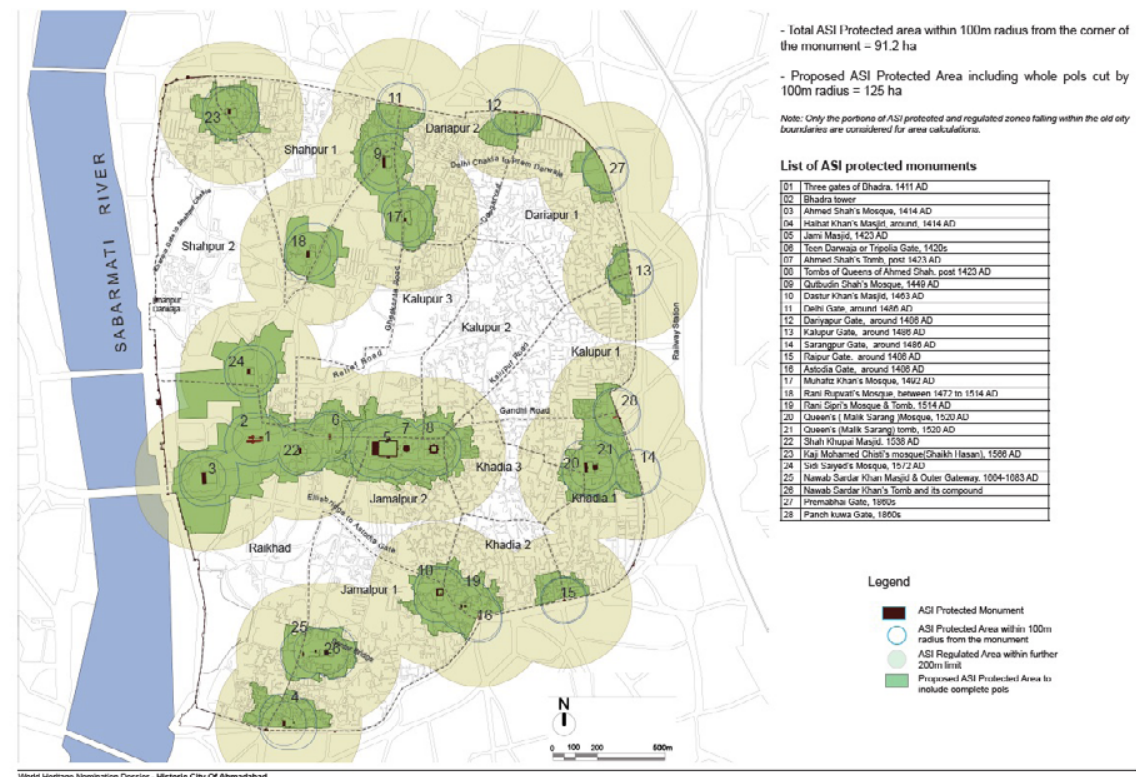
Map showing the old walled city of Ahmedabad and the protected monuments of the area. The walled city coincides with the site inscribed in the World Heritage List. Its buffer zone extends around the walls Source UNESCO. “Historic city of Ahmadabad”